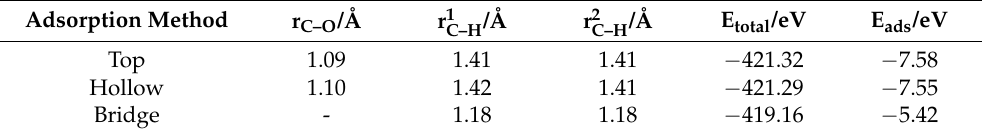
Table 1. System energy, adsorption energy and related parameters of the three forms of formaldehyde adsorption on the intrinsic Ti 3 C 2 surface.